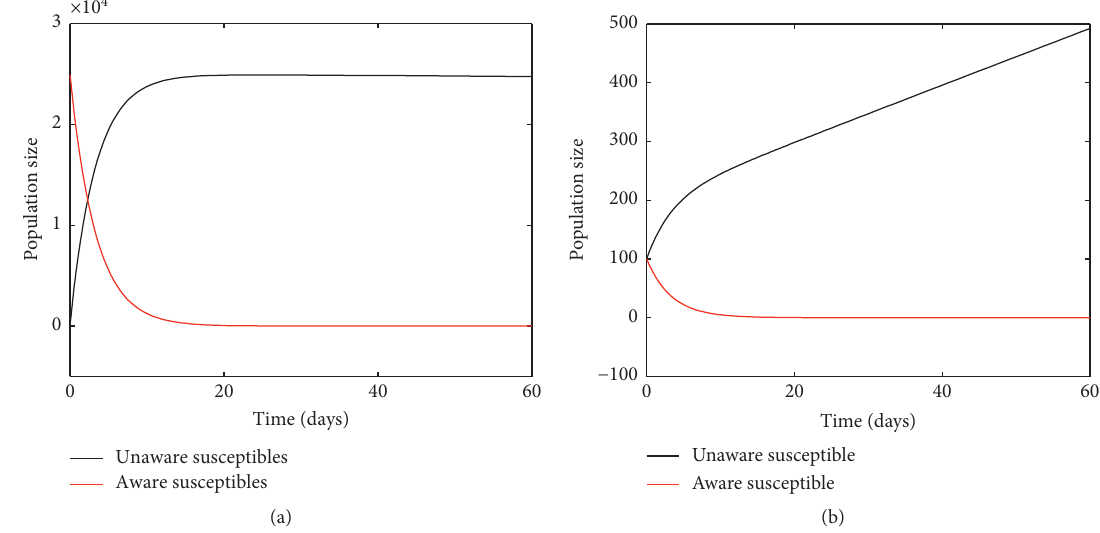
Figure 3: Stability of the disease-free steady state. (a) With parameter values β � 0 . 0001865 and β � 0 . 00145 , β � 0 . 046, and β � 0 . 00007498. Choosing initial values S β � 0 . 0417 , c 1 1 2 remaining parameter values is as in Table